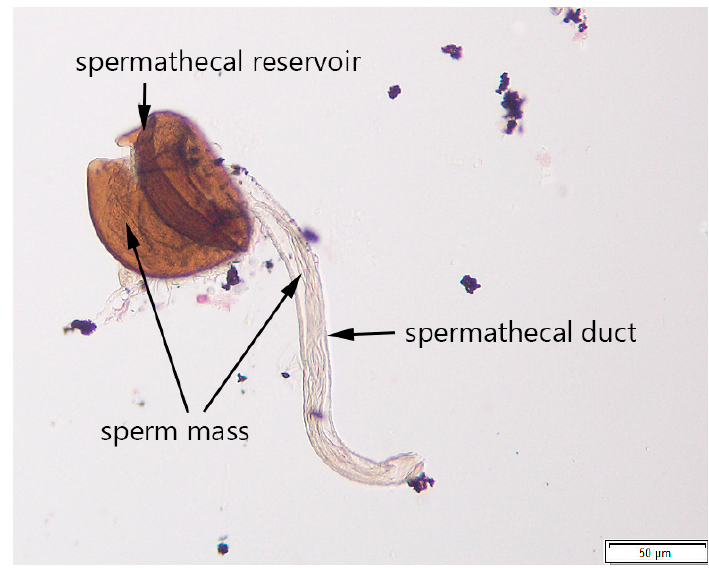
Figure 3. A spermatheca of a mated Drosophila suzukii female under the compound microscope at 20× objective lens; the scale is 50 µm (Image by Claire Mattmiller).